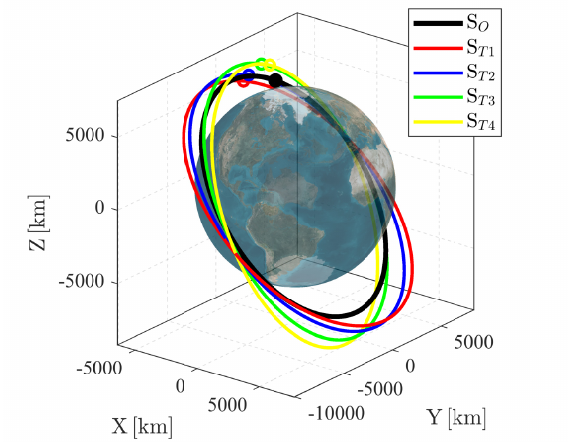
Figure 3. Illustration of the nominal orbits of the observer and